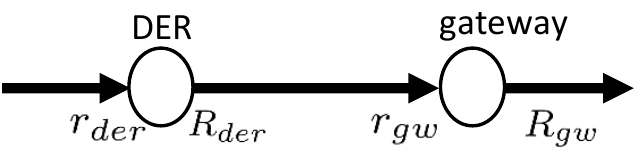
Figure 4. Simple concatenation of network